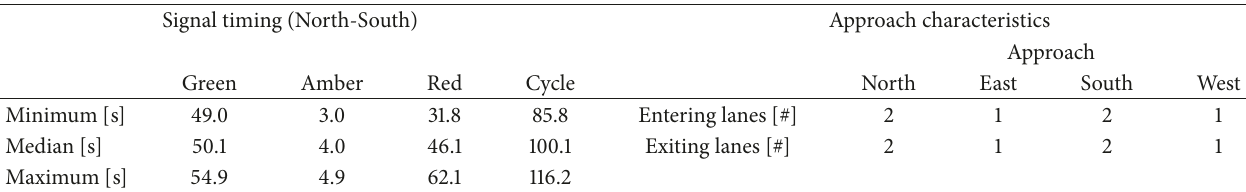
Table 2: Signalized intersection characteristics